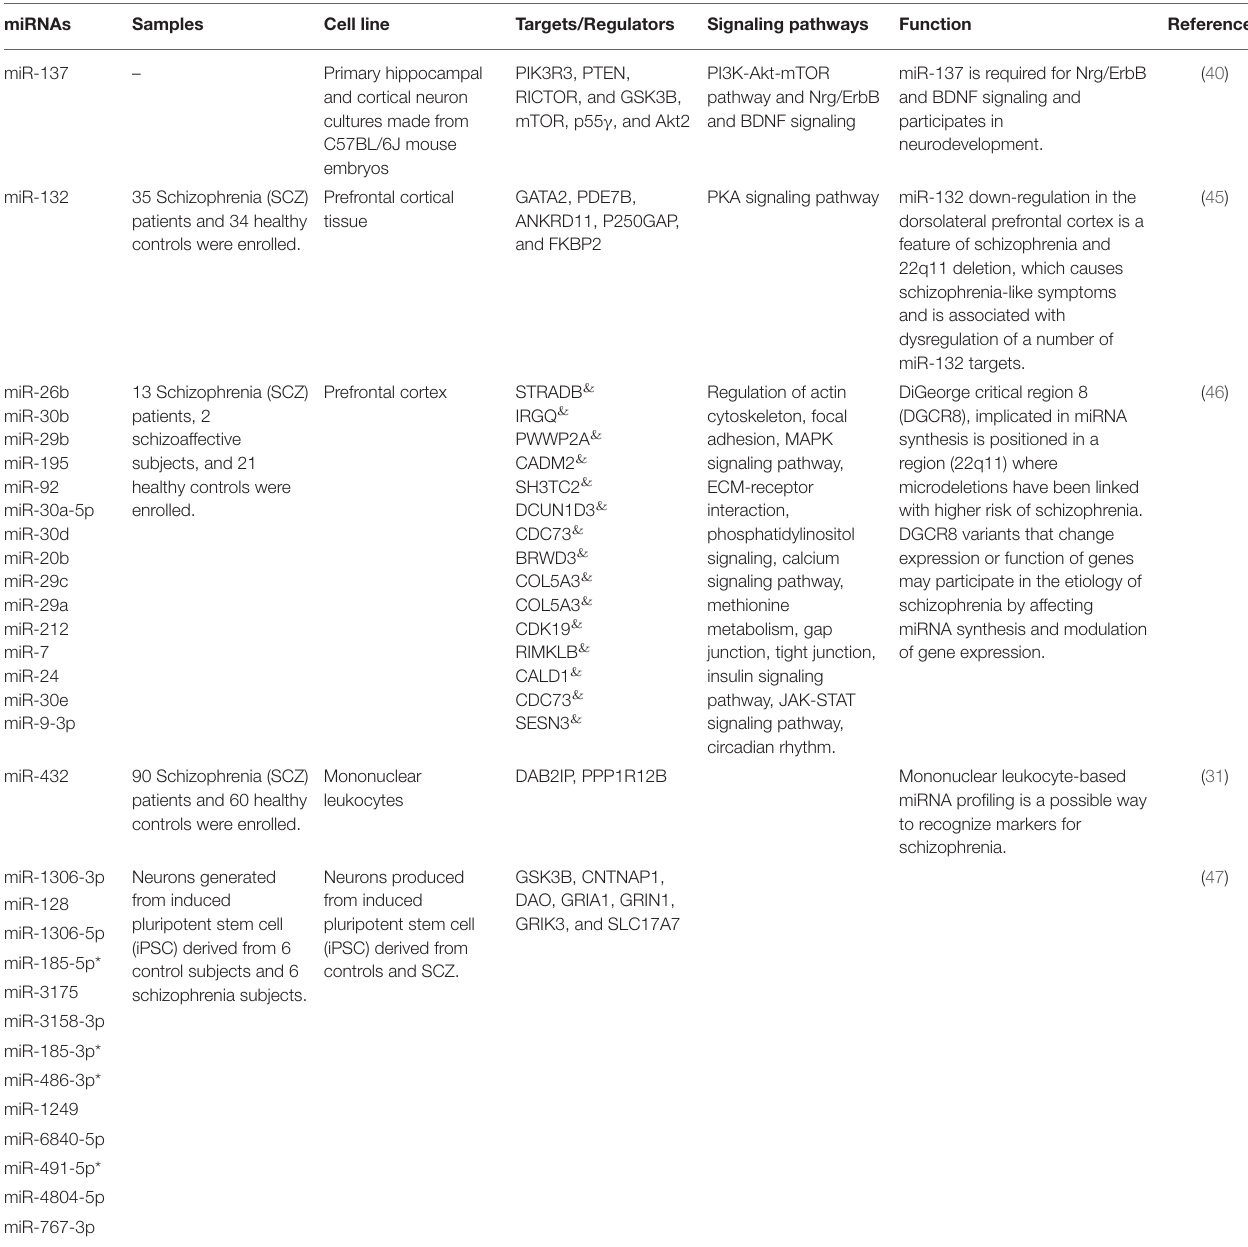
TABLE 4 | Down-regulated miRNAs in schizophrenia [ & Top targets based on the predictions of miRDB (http://www.mirdb.org/), empty cells show that this information has not been provided in the main articles].